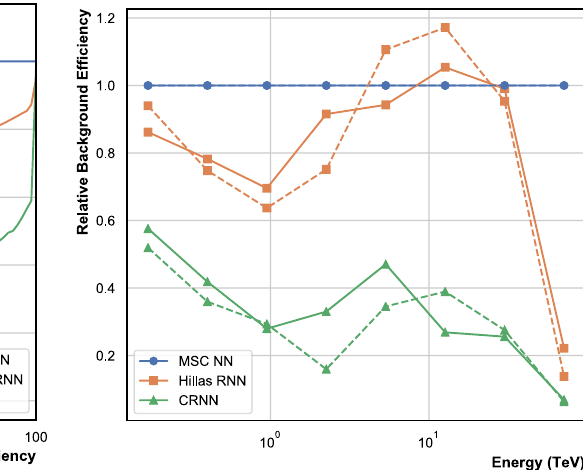
Fig. 5 Left: Comparison of background rejection performance (as a ratio to mean scaled network performance) vs energy-dependent sig- nal cut for the two recurrent networks. Right: Energy dependence of background rejection performance (as a ratio to mean scaled network